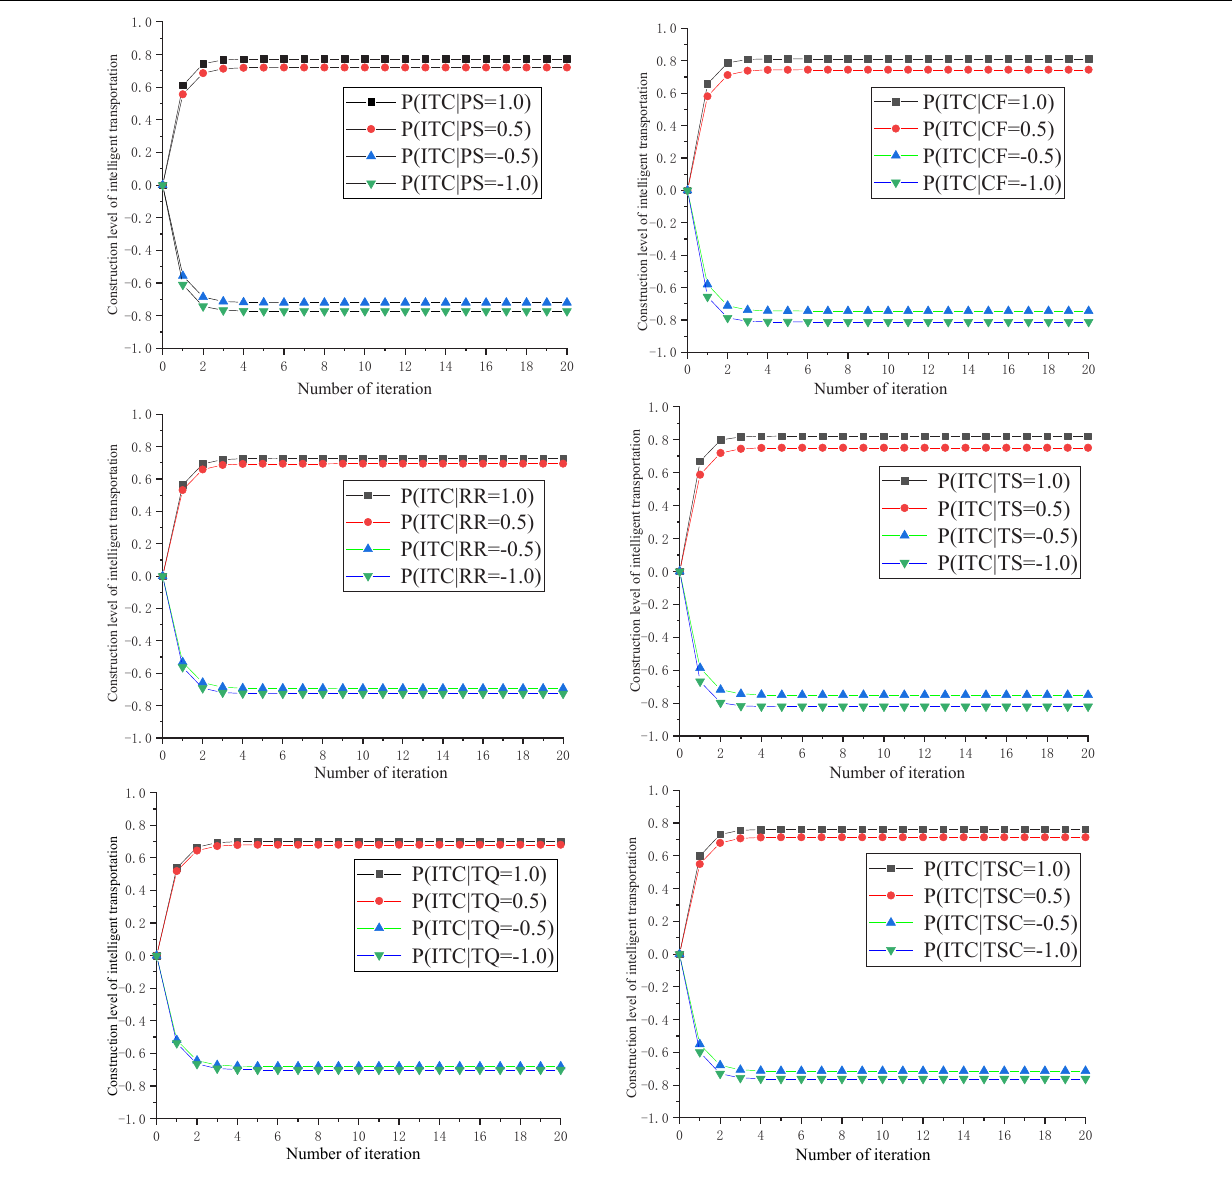
FIGURE 2 | Impacts of variables on the ITC. Policy support (PS), traffic sector control (TSC), technical support (TS), communication foundation (CF), residents’ recognition (RR), talent quality (TQ), and intelligent transportation construction (ITC).